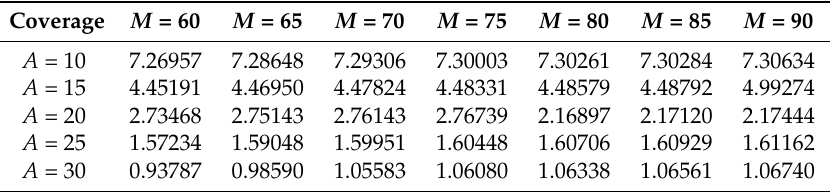
Table 2. Reinsurance Pricing across All Coverage Layers.